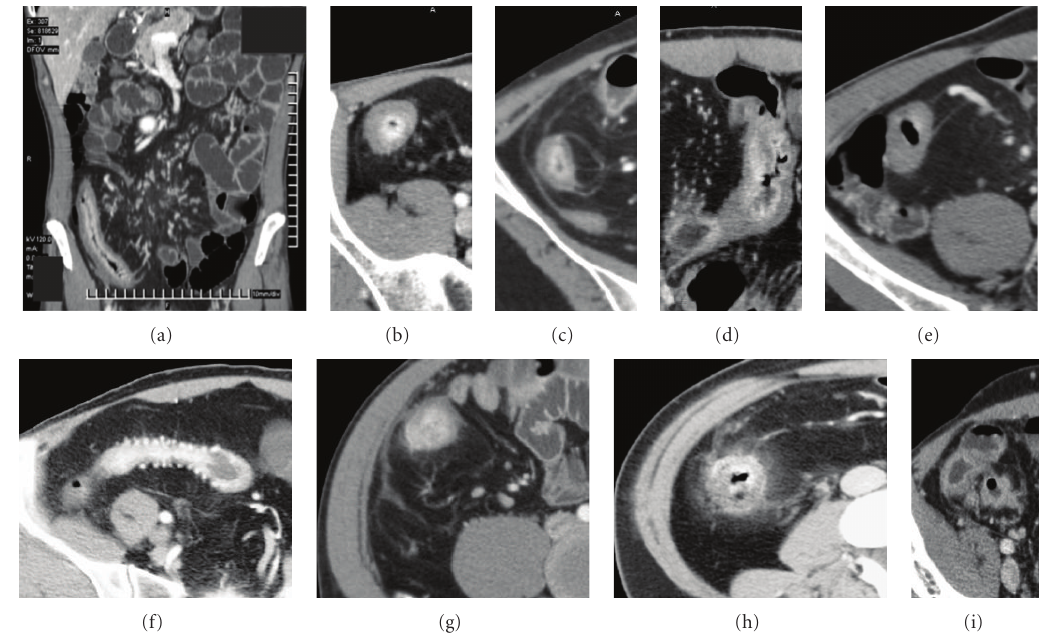
Figure 5: MDCT-E. Intraintestinal findings : intramural (a), (b) wall thickening (b) (“double halo sign”), (c) hyperemia of the mucosa, (d) ulcer, (e) stenosis, extramural (f) engorgement of vasa recta (“comb sign”). Extraintestinal findings : (g), (h) lymph nodes involvement and mesenteric fat stranding, (i)